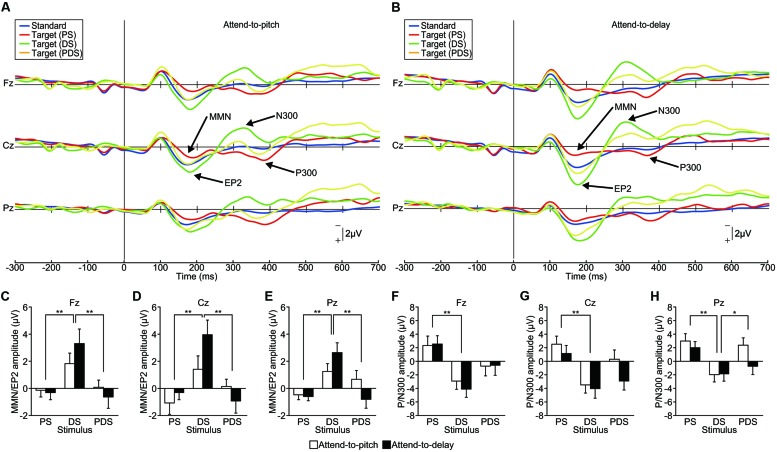
Functional dissociation between the EP2/N300 and MMN/P300 (Experiment 3). (A,B) Grand-averaged ERP waveforms elicited by pitch-deviant (PS), delayed (DS), and pitch-deviant delayed (PDS) feedback (action conditions only, n = 16). The participant was instructed to attend to either (A) pitch-deviant (PS and PDS) or (B) delayed (DS and PDS) auditory feedback. (C–H) The amplitude of the MMN/EP2 and P/N300 at each electrode. (C–E) Two-way repeated-measures ANOVAs examining the amplitude of the MMN/EP2 revealed a significant main effect of the type of feedback [Fz: F(1,90) = 9.14, p < 0.01, effect size η2 = 0.17; Cz: F(1,90) = 9.31, p < 0.001, effect size η2 = 0.17; Pz: F(1,90) = 10.08, p < 0.001, effect size η2 = 0.18] but no main effect of selective attention (p > 0.3). A post hoc analysis (Tukey’s HSD test) revealed significant differences between PS and DS and between DS and PDS at all electrodes (p < 0.01). (F–H) Two-way repeated-measures ANOVAs examining the amplitude of the P/N300 revealed significant main effects of the type of feedback [Fz: F(1,90) = 9.25, p < 0.001 effect size η2 = 0.17; Cz: F(1,90) = 9.01, p < 0.001 effect size η2 = 0.17; Pz: F(1,90) = 8.02, p < 0.001 effect size η2 = 0.15]. A post hoc analysis (Tukey’s HSD test) revealed significant differences between PS and DS at all electrodes (p < 0.01) and between DS and PDS at Pz (p < 0.05). ∗p < 0.05, ∗∗p < 0.01. Error bars represent SEM.